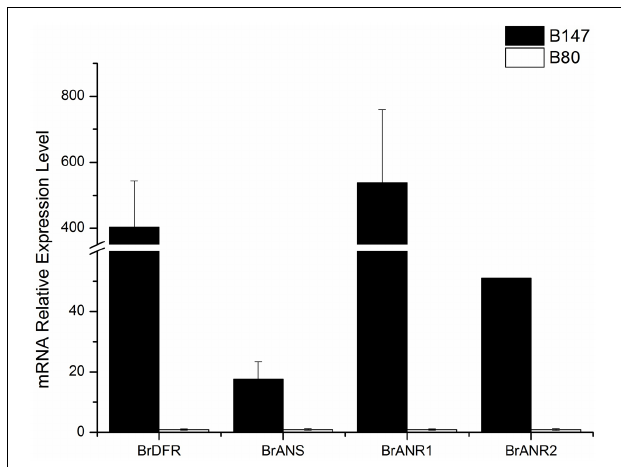
FIGURE 5 | Expression levels of four late biosynthetic genes (LBGs), BrDFR , BrANS , BrANR1, and BrANR2 in seeds of brown-seeded line B147 and yellow-seeded line